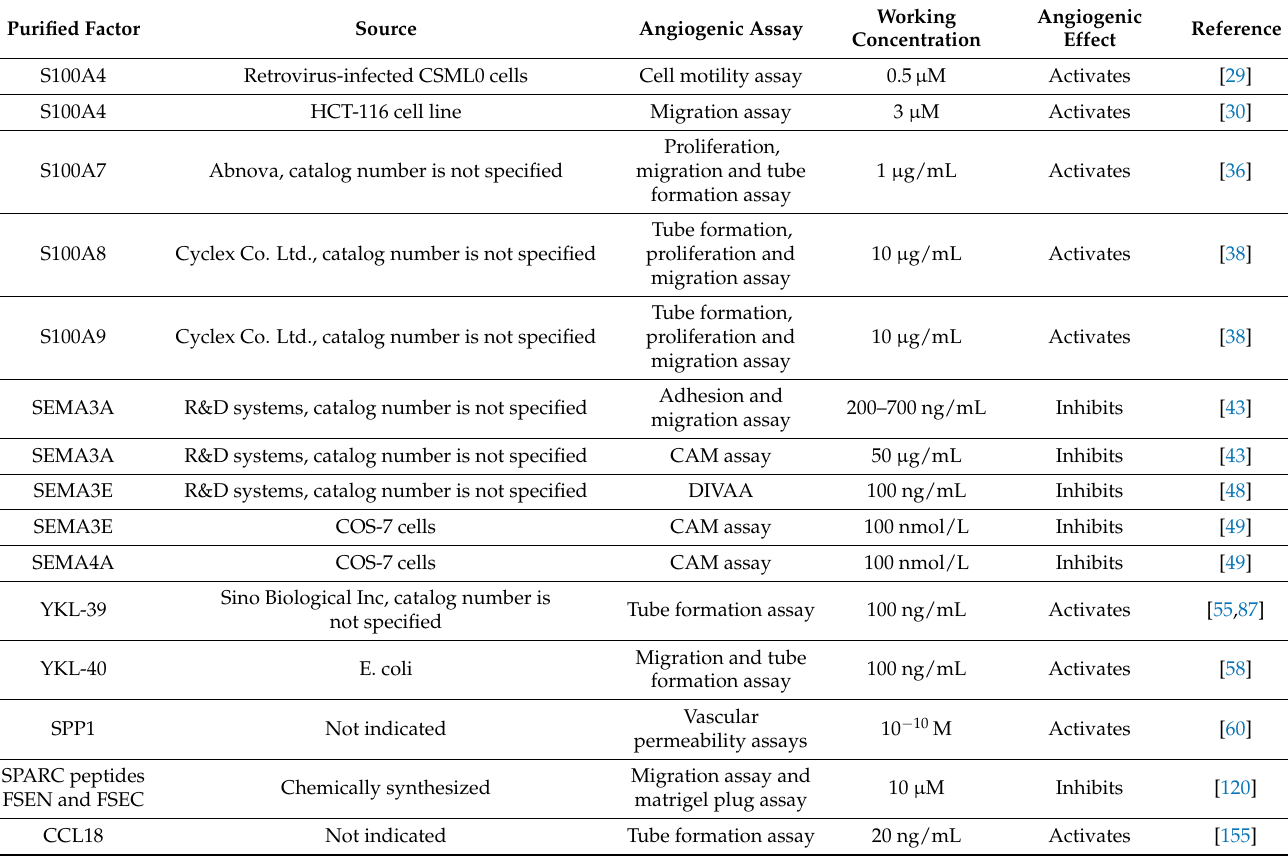
Table 2. The mode of direct action of recombinant proteins involved in